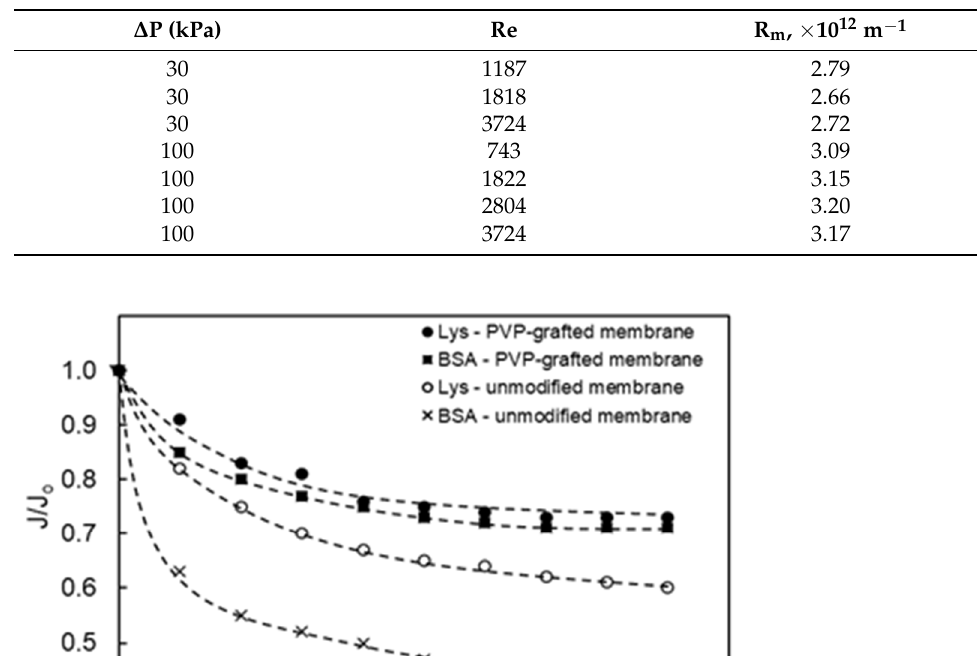
Figure A1. Permeate flux dependence on transmembrane pressure for the unmodified, silylated, hydrolyzed, and PVP-grafted membranes (R 2 > 0.98 for the linear plots). The measurements were at a tube-side Reynolds number of 3600. Table A1. Effect of Reynolds number (Re) on hydraulic resistance of PVP-grafted membranes for two different transmembrane pressures, 30 and 100 kPa (corresponding permeate flux of 6.4 × 10 − 4 and 1.9 × 10 − 5 m/s determined for D.I. water at pH 7). The unmodified membrane resistance was ~2.1 × 10 − 12 m − 1 at 100 kPa.